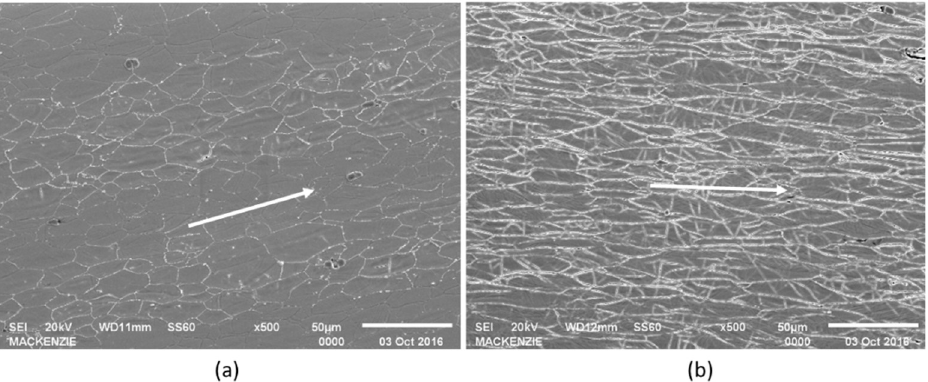
Figure 8. Micrographs of the longitudinal section of the Inconel 625 specimens tensile tested at ( a ) 600 °C and at ( b ) 700 °C in the region close to the fracture (3 mm to the fracture). The arrows are indicating the tensile test direction.